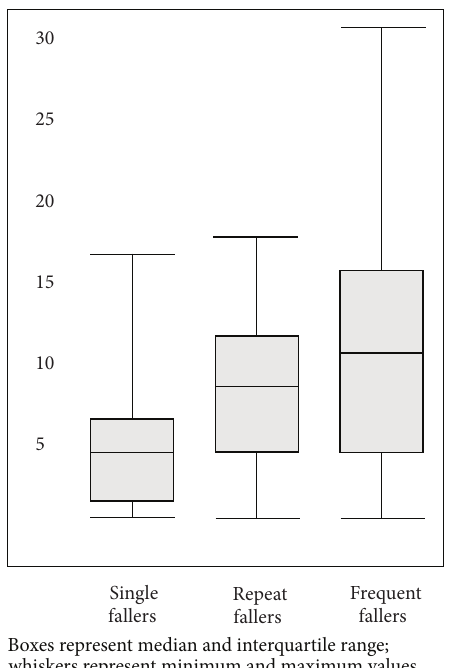
Boxes represent median and interquartile range; whiskers represent minimum and maximum values Figure 2: Box and whisker plot: time since diagnosis (in years) by